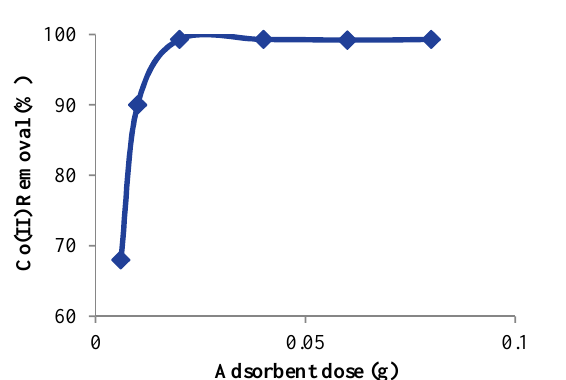
O nanoparticles 2 4